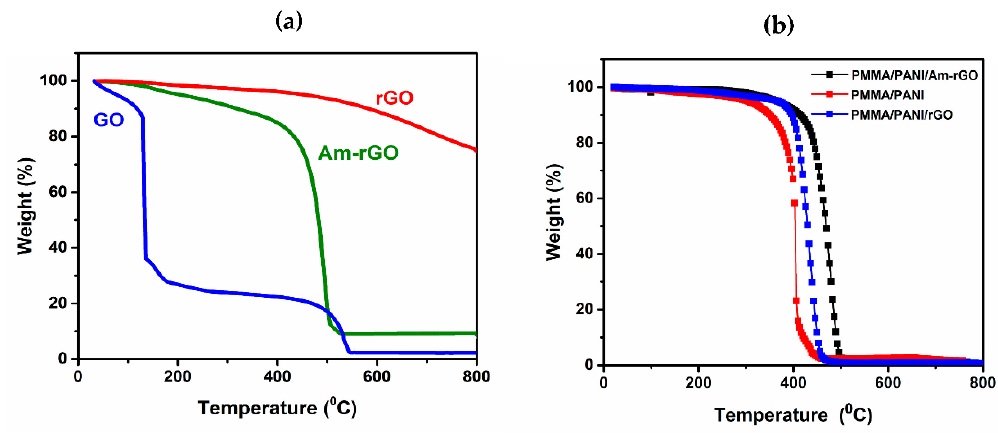
Figure 8. TGA curves ( a ) of GO, rGO and Am-rGO; and ( b ) for electrospun PMMA/PANI/Am-rGO, PMMA/PANI/rGO and PMMA/PANI nanofibers.